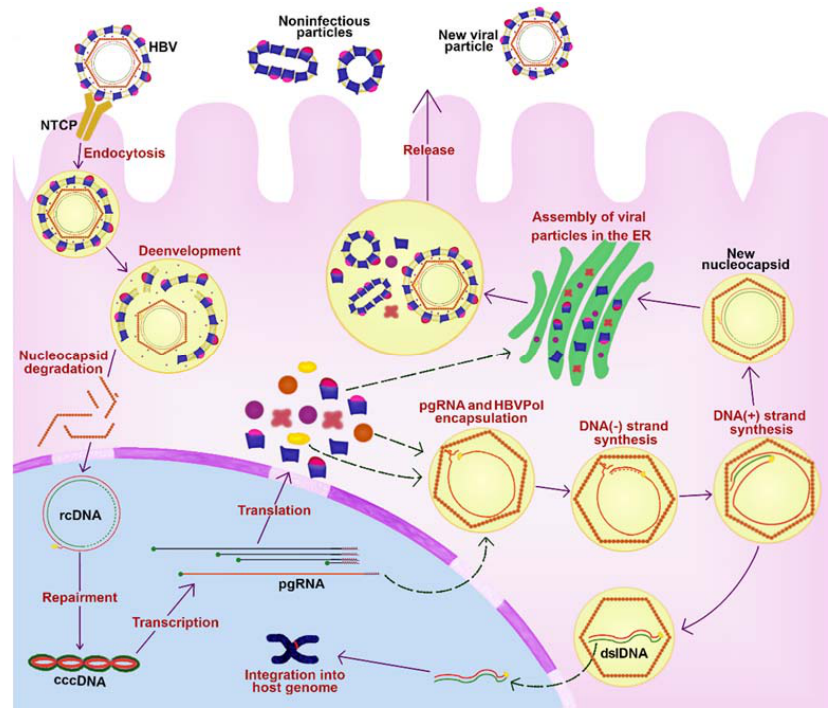
Figure 3. HBV replicative cycle. HBV undergoes endocytosis through the NTCP. Inside the cell, the